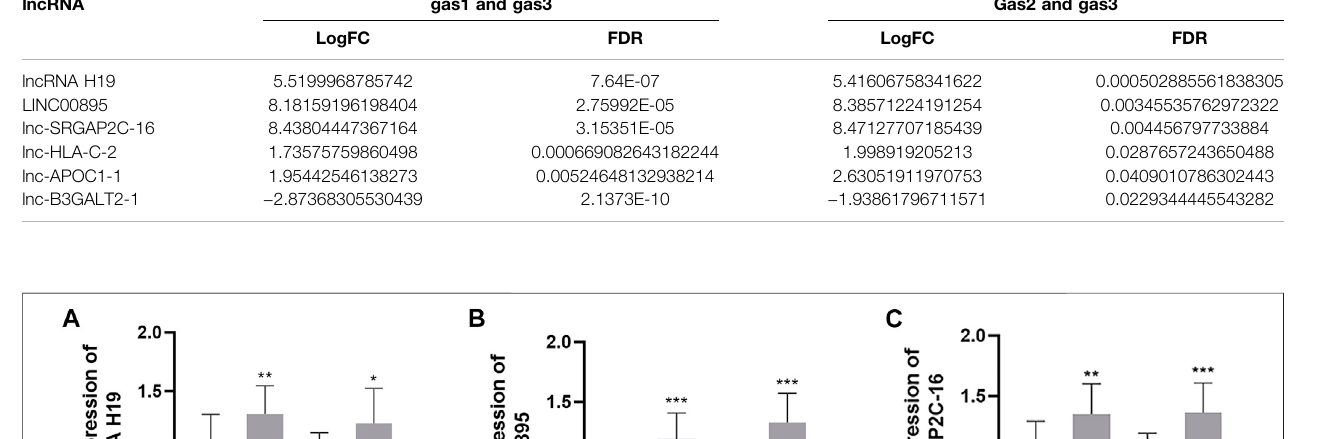
TABLE 2 | TheLogFC and FDR ofsixdifferentiallyexpressed lncRNAs between thegastritis group(gas1) and thegastric cancergroup (gas3) aswell asbetweenthe gastric precancerous lesions group (gas2) and the gastric cancer group (gas3). lncRNA